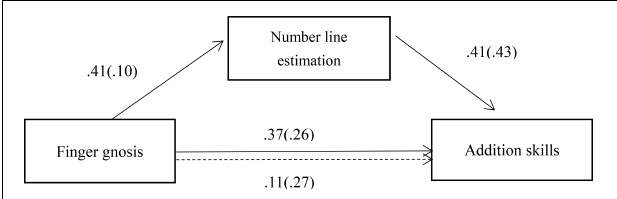
FIGURE 1 | Solid line indicates a significant direct path from finger gnosis to number line estimation, from finger gnosis to addition skills, and from number line estimation to addition skills. Dotted line denotes a non-significant path from finger gnosis to addition skills when controlling for number line estimation. Standardized OLS regression coefficients and standard errors (in brackets) were on the